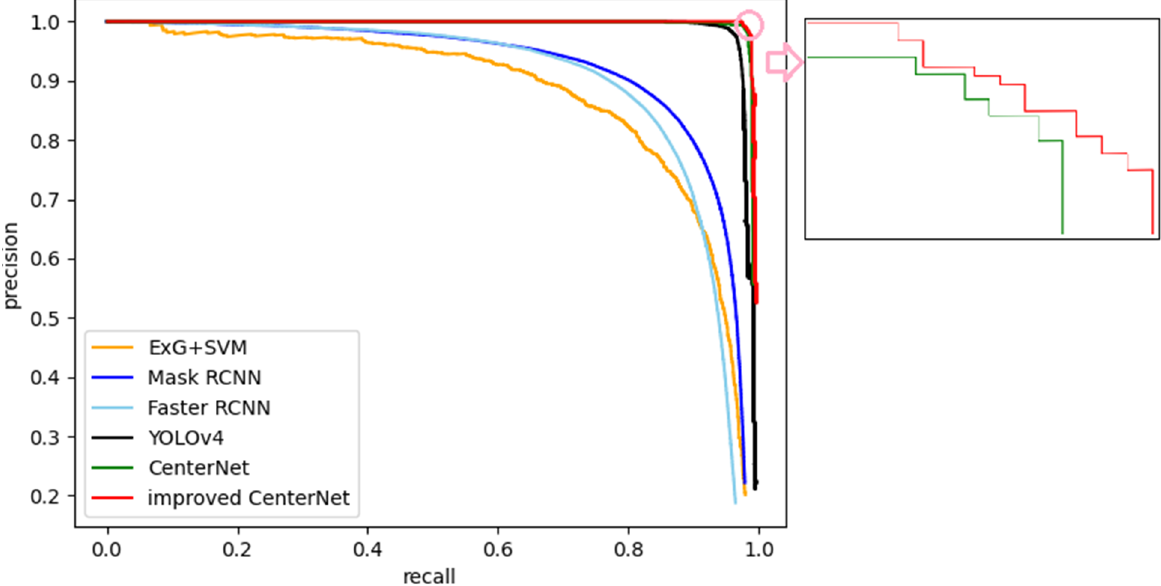
Figure 7. P-R curves for six detection detectors.